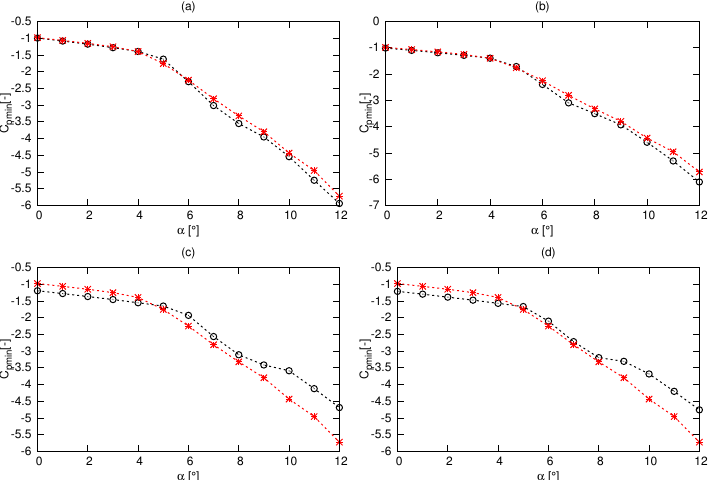
Figure 11. C pmin of the reference and optimized hydrofoils of the second case of 3-D optimization, where ( a ) is C pmin of HF-3D-2-1, ( b ) is C pmin of HF-3D-2-2; ( c ) is C pmin of HF-3D-2-3, ( d ) is C pmin of HF-3D-2-4. The red and black lines denote optimized and reference